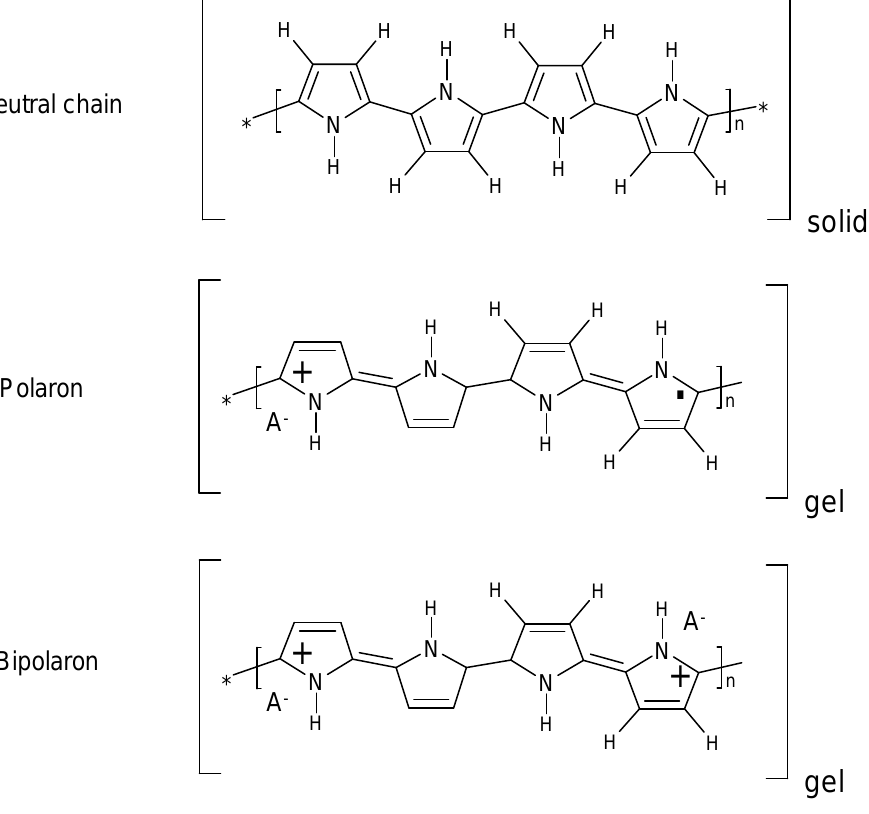
bipolarons (dications). Counterions (A - ) penetrate from the solution for charge